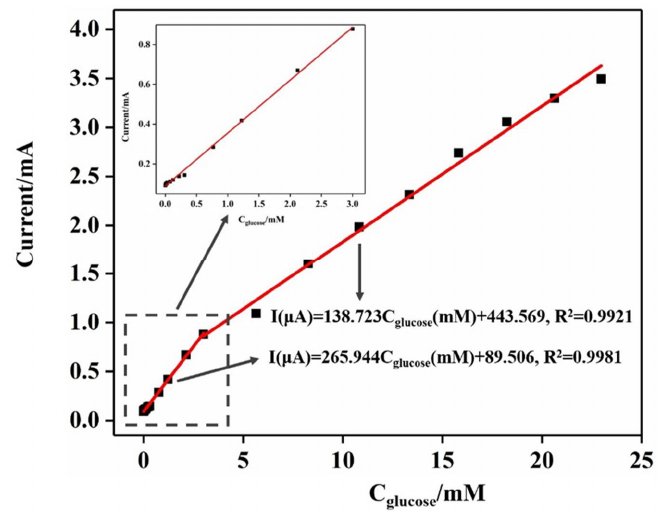
Table 1. Comparison of the performance of the proposed sensor and those of similar ones described in the literature.